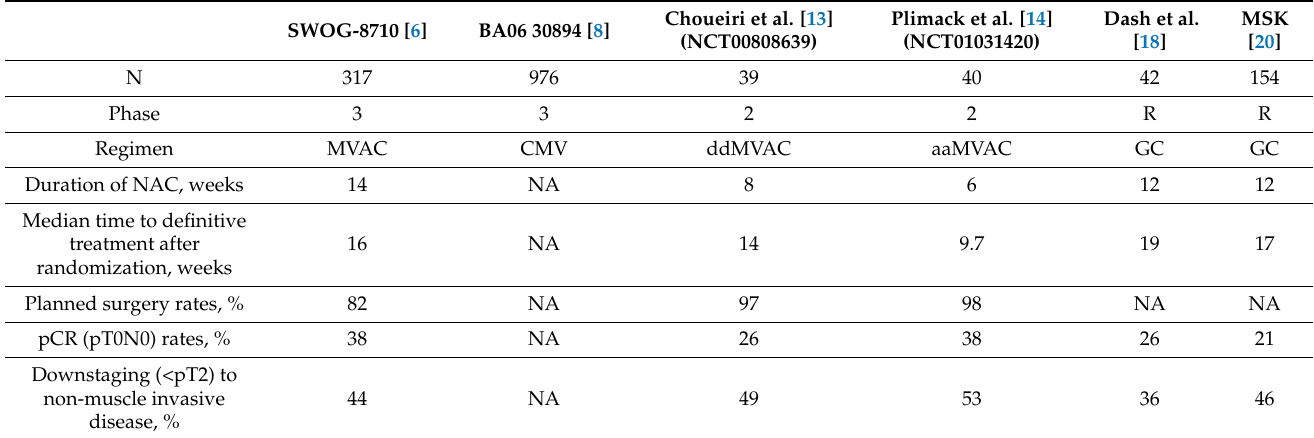
Table 1. Summary of trials for cisplatin-based neoadjuvant chemotherapy in muscle-invasive bladder cancer.